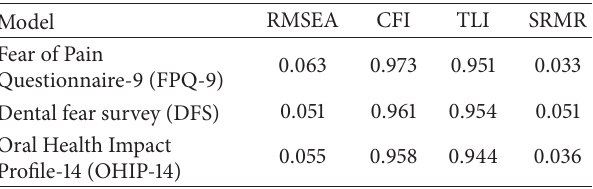
Table2:Modelfitindicesproducedbyconfirmatoryfactoranalyses.